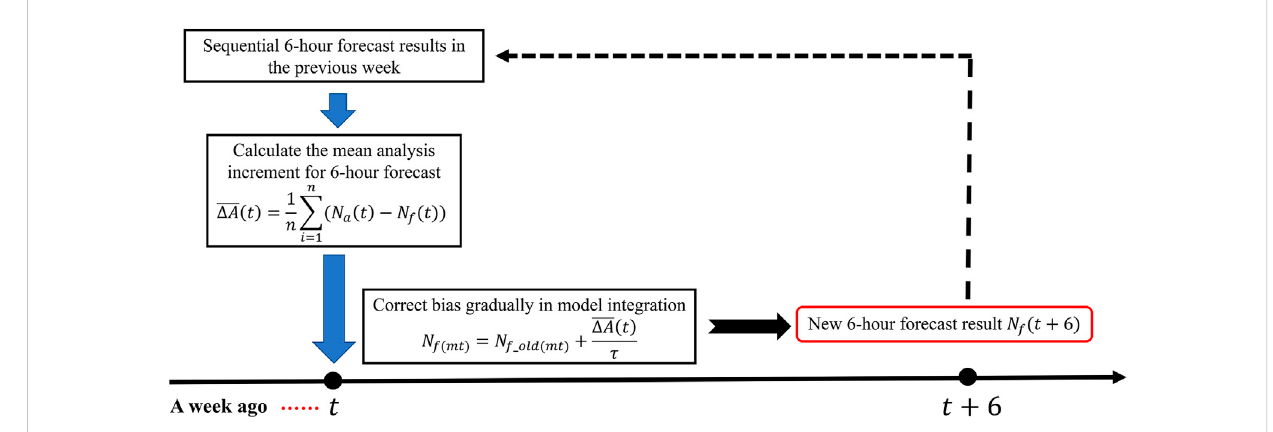
The fl owchart of the